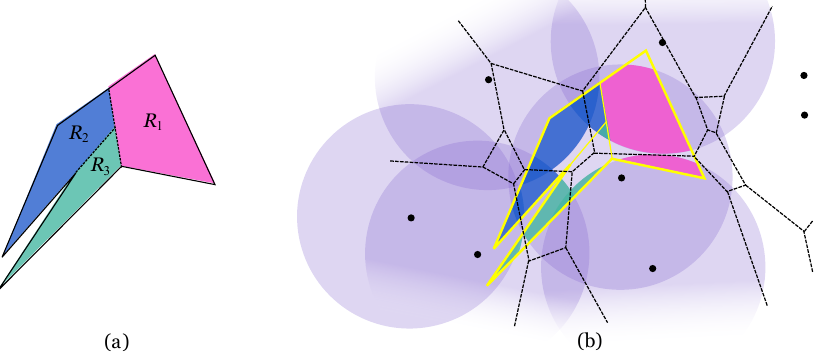
, A and A are shown in pink, blue and green, 1 2 3